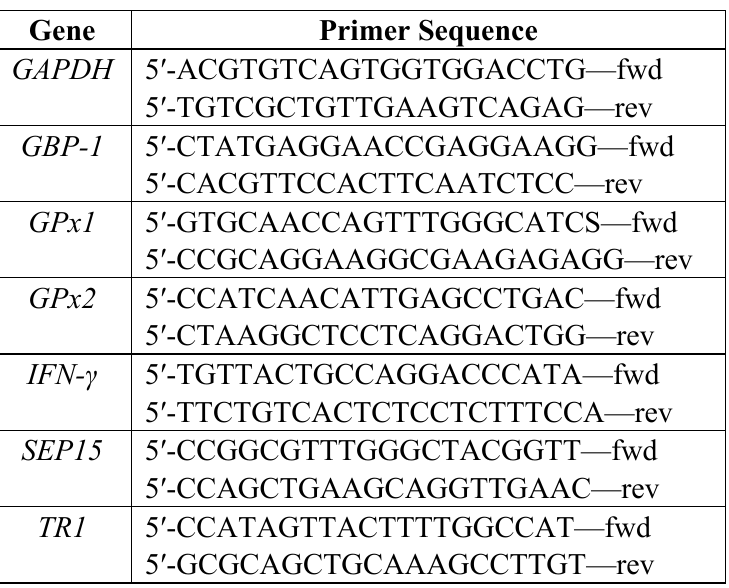
Table 1. Human real-time RT-PCR primers